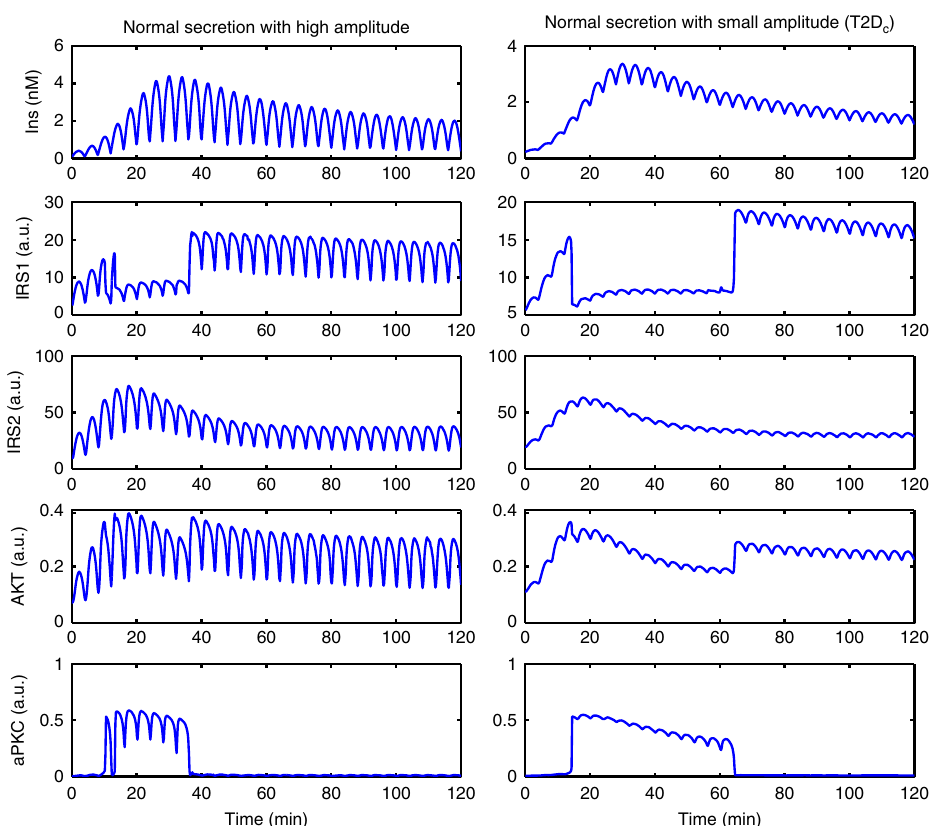
Fig. 6 Responses of the minimal model to insulin with high (left) and low (right) pulse amplitude. The amounts of insulin in the two cases (quanti fi ed by AUC) are equal. See Supplementary Fig. 6 for similar results based on other parameter